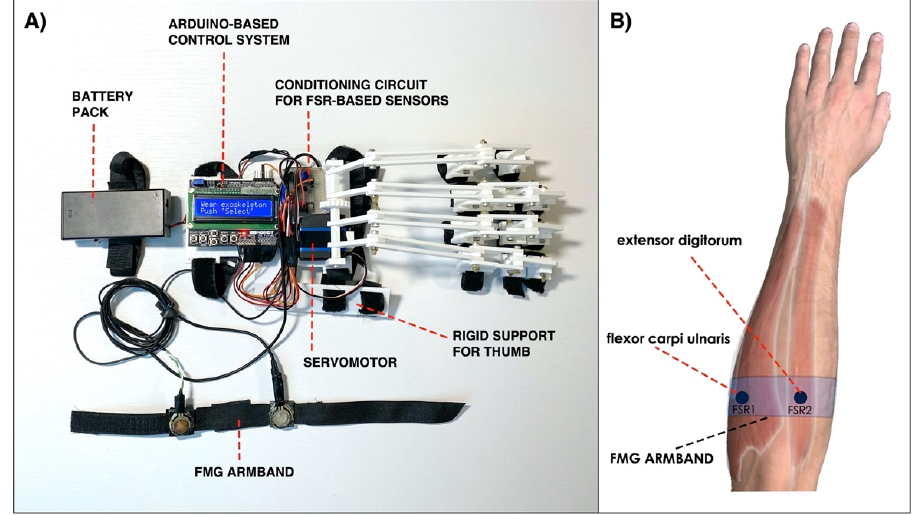
Figure 4. ( A ) Picture of the hand exoskeleton (top view): the actuator (25 kg cm servomotor), the Arduino UNO board with the superimposed LCD shield, the FMG armband based on 2 FSR-based sensors, the conditioning circuit for the FSR-based sensors and the battery pack (2 × 3.7 V, 3000 mAh) are highlighted; ( B ) FSR-based sensors positioned on the flexor carpi ulnaris and the extensor digitorum of the user’s forearm.